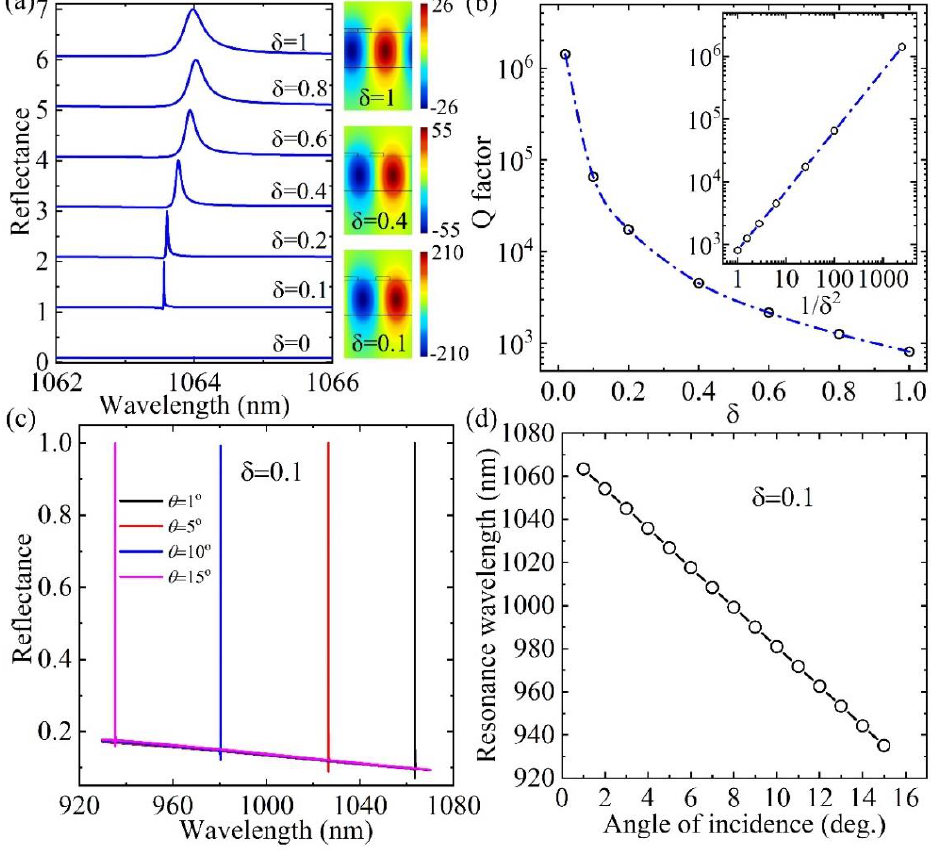
Figure 2. ( a ) The reflectance spectra in GMR nanostructures of different δ at θ = 1 ◦ . The electric field | E y /E 0 | distributions in the nanostructures of δ = 0.1, 0.4 and 1 at their resonance modes are shown, respectively. ( b ) Q -factor versus δ . The Q factor and δ − 2 agree with the linear fitting well, as shown in the inset. ( c ) The reflectance in GMR nanostructure of δ = 0.1 versus the incident angles. ( d ) The dependence of the resonance wavelength on incident angles in the GMR nanostructure of δ =